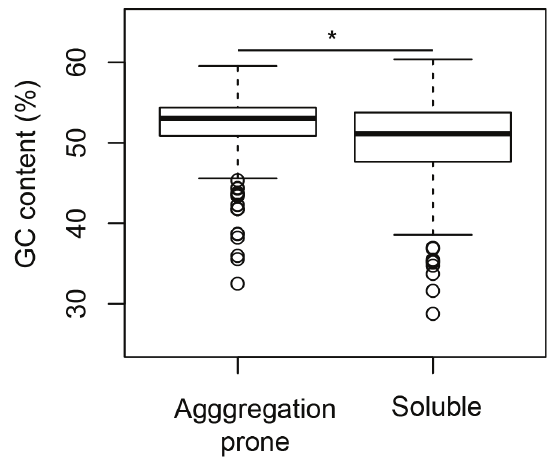
Figure 4. Aggregation-prone proteins are richer in GC-content than soluble proteins. In E. coli , aggregation-prone proteins contain higher GC-content than soluble proteins. Mann-Whitney test p-value (*) is